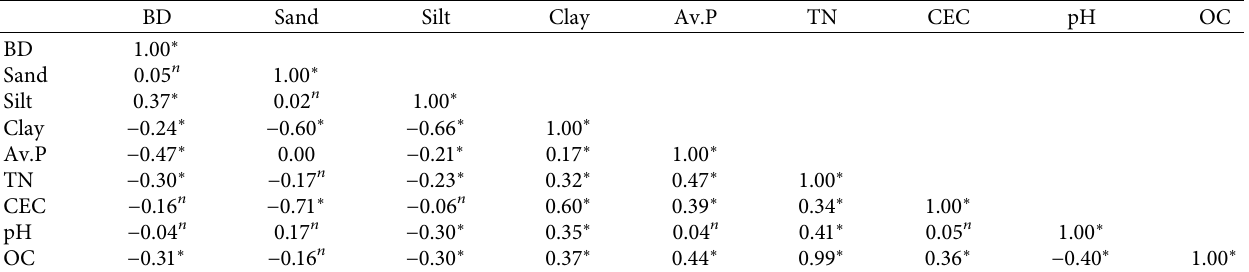
Table 3: Pearson correlation matrix for the selected soil properties in the study area. BD